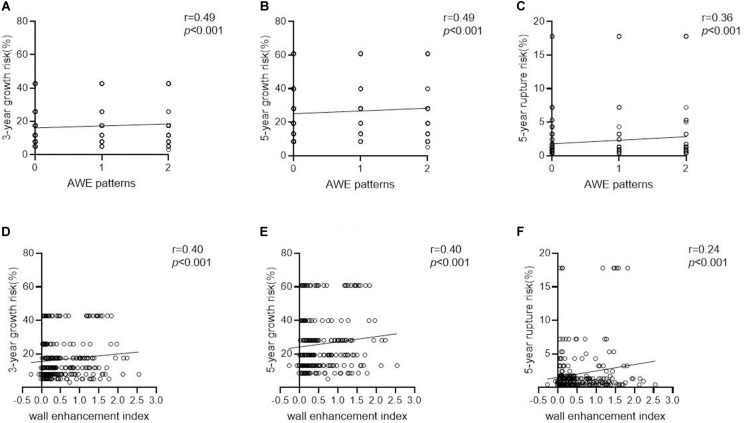
The correlations between AWE patterns/WEIs and aneurysm growth/rupture risk. (A–C) The AWE patterns and aneurysm growth/rupture risk. (D–F) The WEIs and aneurysm growth/rupture risk).